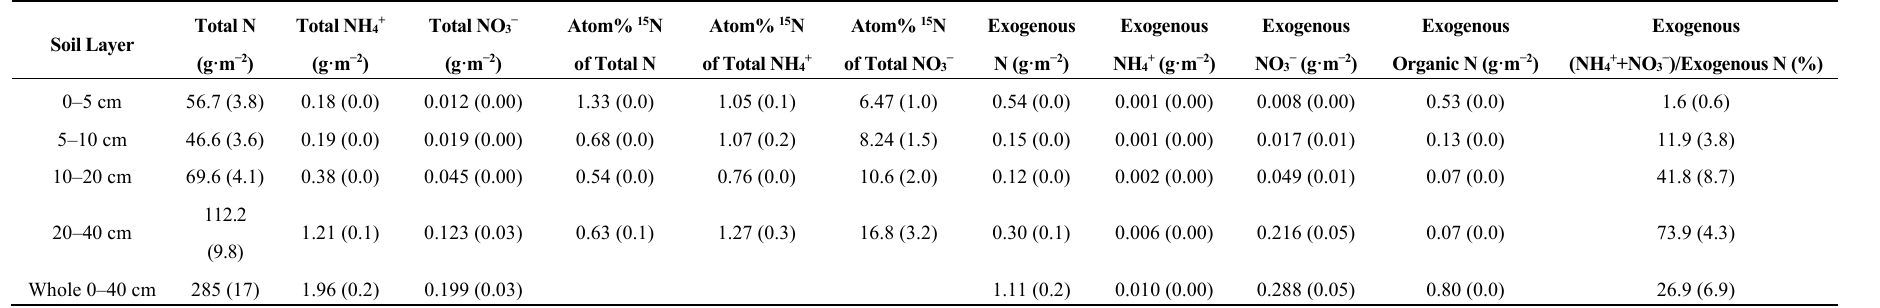
Table 3. Contents and 15 N abundances in soil N pools of the N addition treatment eight months after N addition (mean ± standard error (se); n =